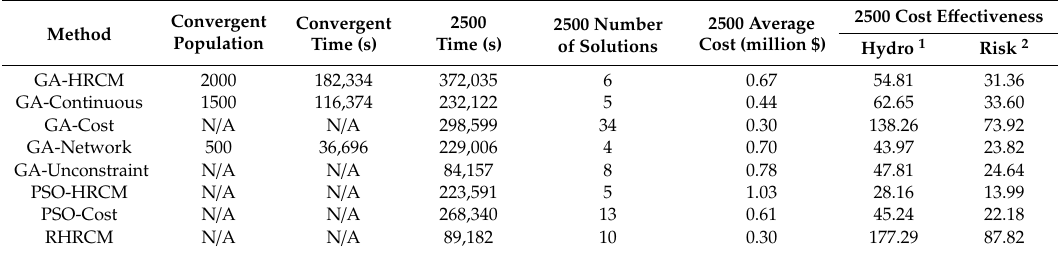
Table 4. The summarized results of the seven methods with scenario